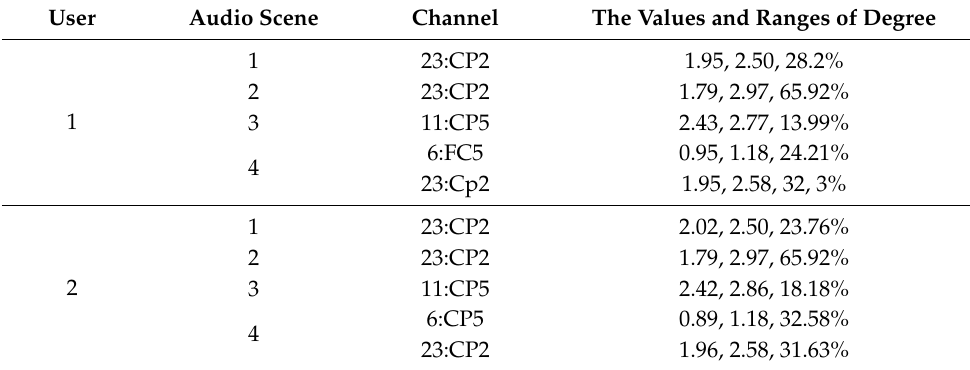
Table 1. The values and ranges of